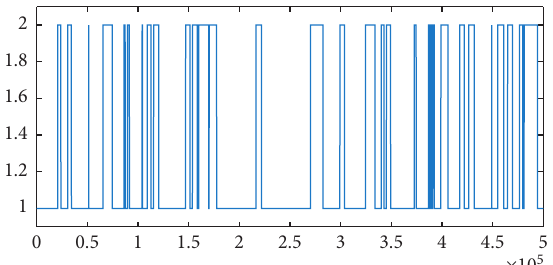
Figure 1: The trajectory of the Markov chain r ( t )